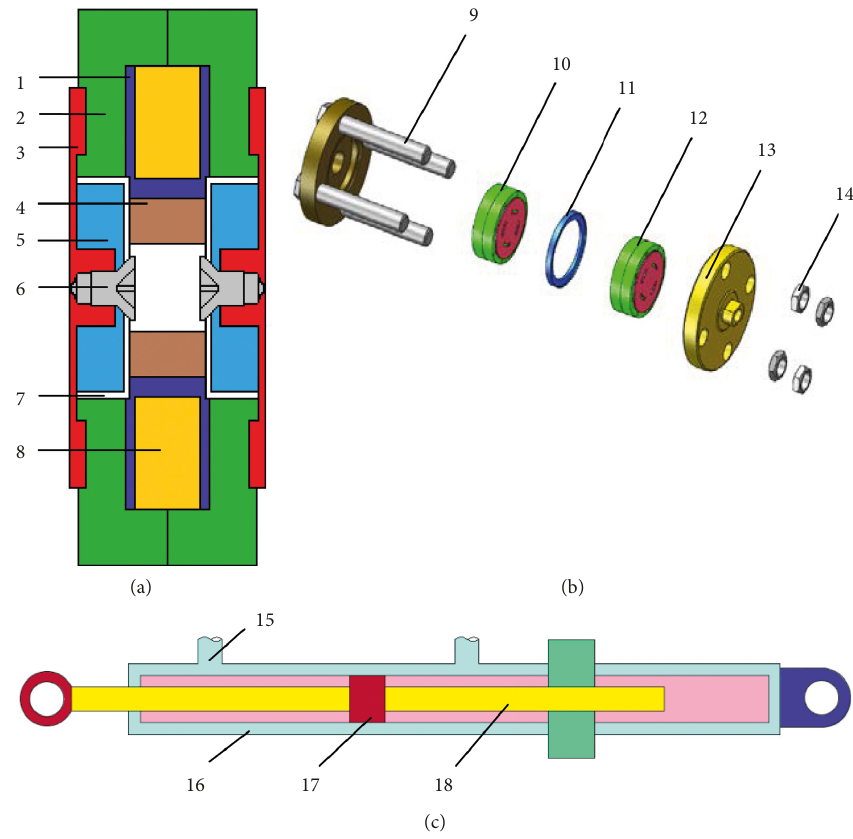
Figure 40: Illustration of the MR valve component. (a) Module’s cross-sectional view, (b) exploded view, and (c) schematic of double rod hydraulic cylinder.1 coil bobbin; 2, valve casing; 3, disc holder; 4, orifice core; 5, disc core; 6, bolt 2mm; 7, fluid gap; 8, coil; 9, bolt 6 mm; 10, 1st stage module; 11, flange; 12, 2nd stage module; 13, cap; 14, nut; 15, double inlet port; 16, monotube cylinder; 17, piston; 18, rod